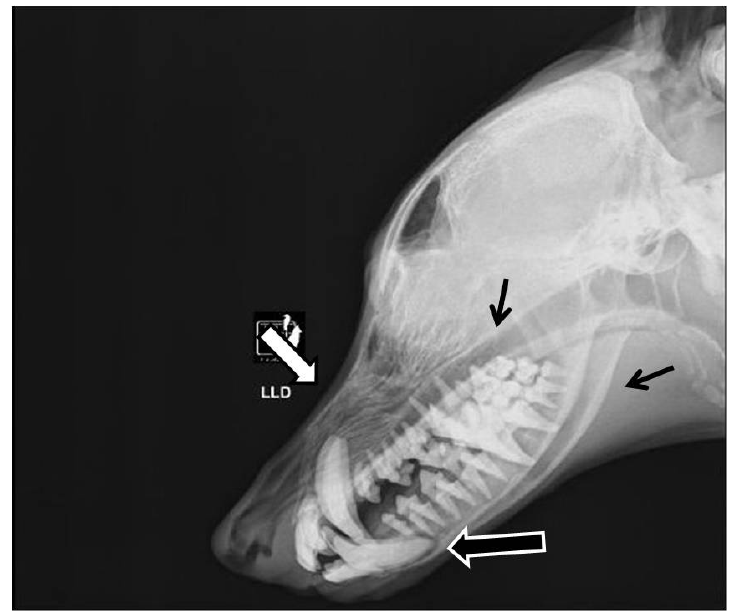
Figura 1. Imagem da maxila e do ramo mandibular com perda moderada de densidade óssea difusa (setas finas), periferia apical, dos dentes, mais definidos e destacados por conta da perda de densidade alveolar (contorno